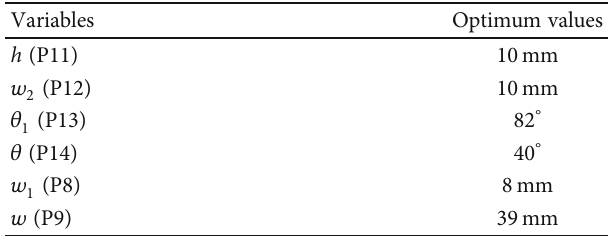
Table 3: Optimum design variables.